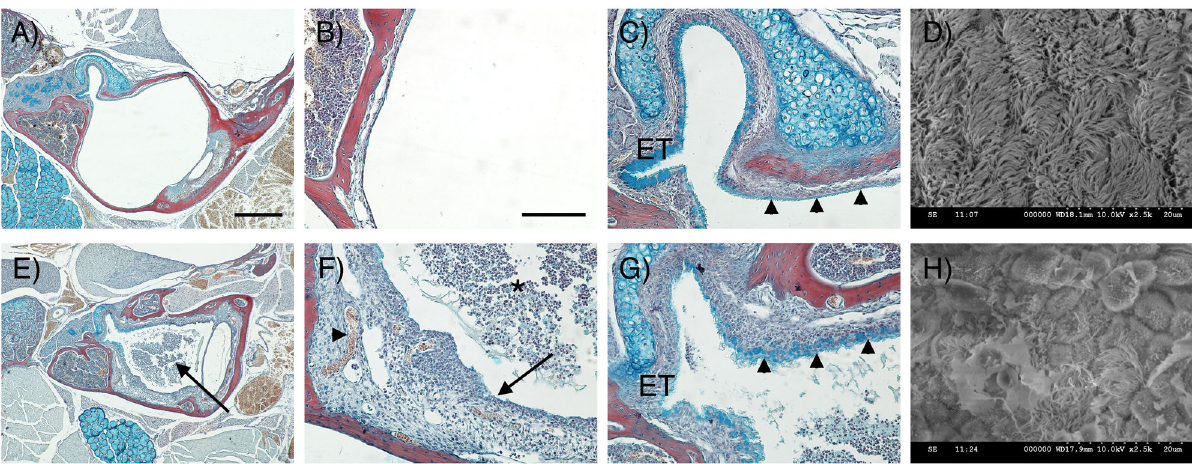
Figure 3. Morphological changes in MEC mucosa and epithelium in Df1/+ mice. (A-C, E-G) Frontal trichrome-stained sections from 11.5-week-old mice showing the middle ear cavity. (D, H) SEM images of middle ear epithelium. (A-D) WT. (E-H) Df1/+ with signs of OM. (A) The middle ear cavity is air-filled in the WT. (B) The mucosa is a thin layer lining the auditory bulla. (C) At the entrance of the Eustachian tube (ET) high levels of alcian blue staining are observed indicating mucin production. Further into the middle ear away from the orifice, staining is less distinct in the WT (arrowheads). (D) A thick lawn of cilia is observed overlying the epithelium near the ET orifice. (E) In Df1/+ mice the middle ear cavity is filled with effusion (arrow). (F) Df1/+ mice show signs of inflammation such as effusion with infiltrated inflammatory cells (asterix), a thickened mucosa (arrow) and hypervascularisation (arrowhead). (G) In addition, increased alcian blue staining is observed within the middle ear at a distance from the ET indicating increased mucin production in Df1/+ mice (compare C and G, arrowheads). (H) Df1/+ mice with OM show reduced numbers of cilia that appear shortened and rarefied. Dorsal is top in A-C, E-G. Scale bar: 500 μm (A, E), 100 μm (B, C, F,